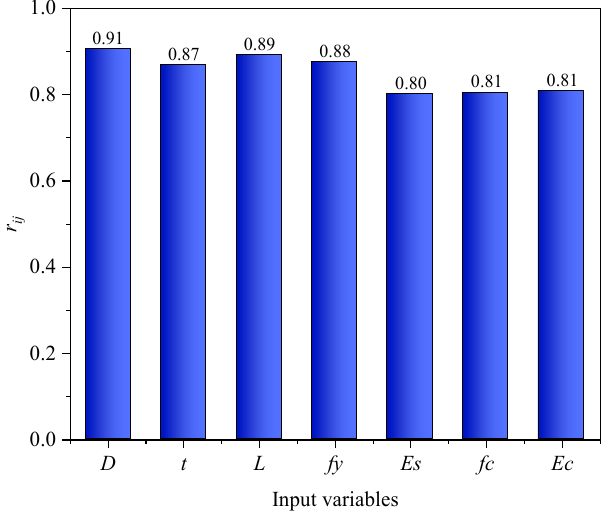
Figure 9. Sensitivity analysis results of seven input variables on the output N u .